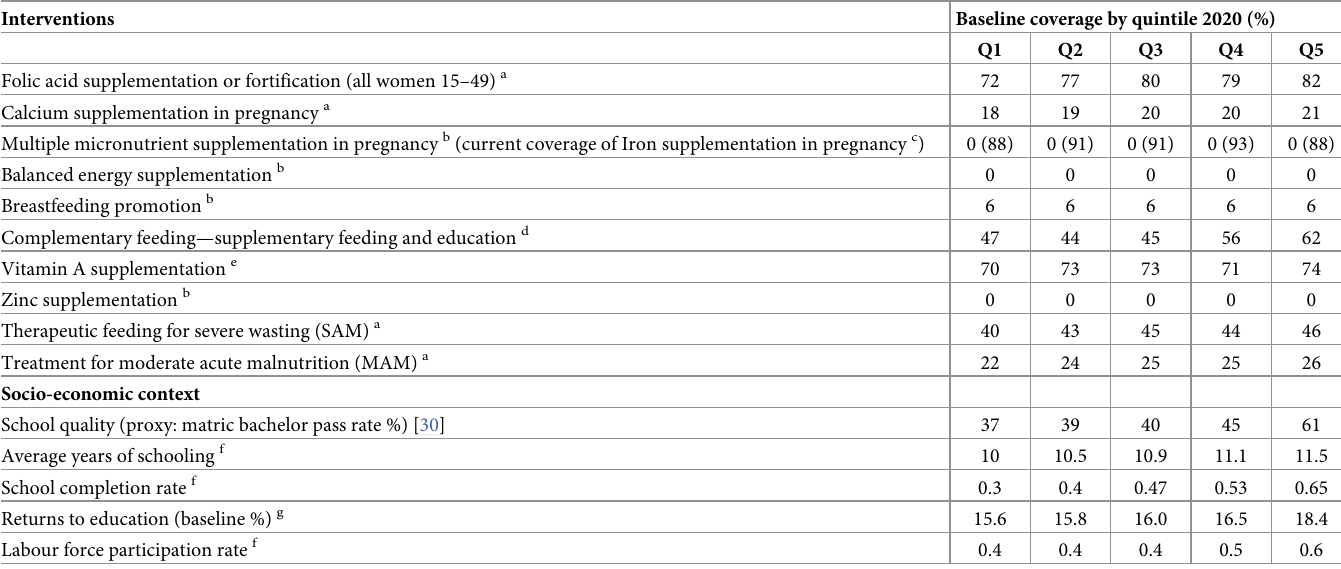
Table 1. Baseline intervention coverage and socio-economic context in South Africa.